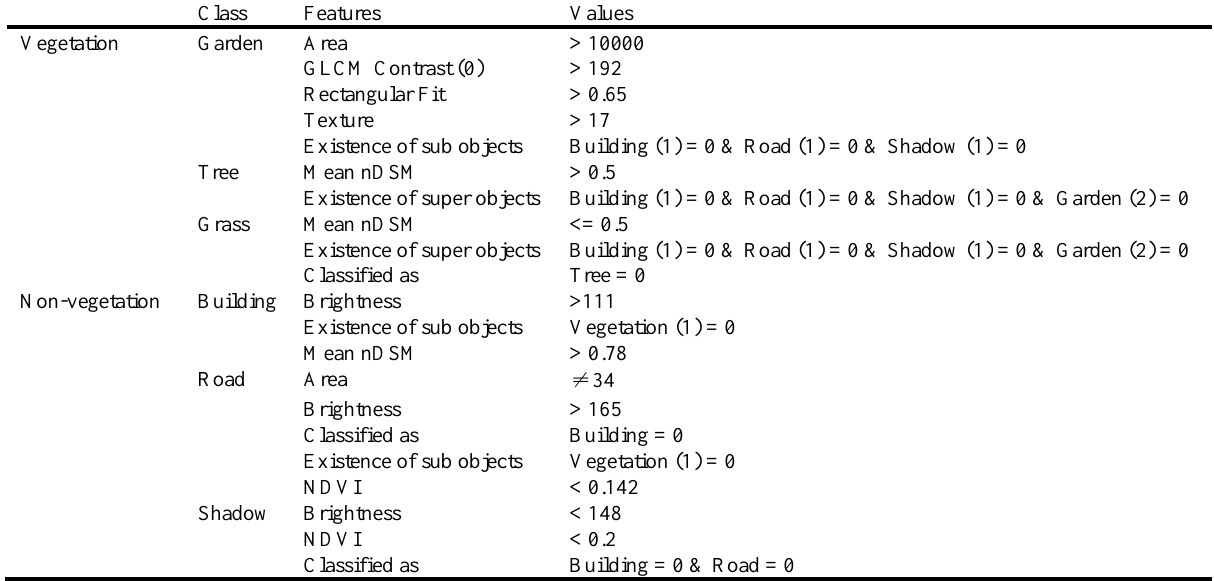
Table 7. Classification hierarchy system of Data 1